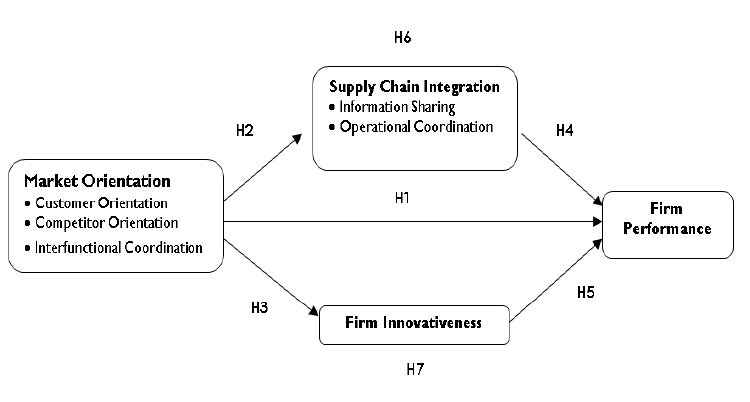
Figure 1. Conceptual Research